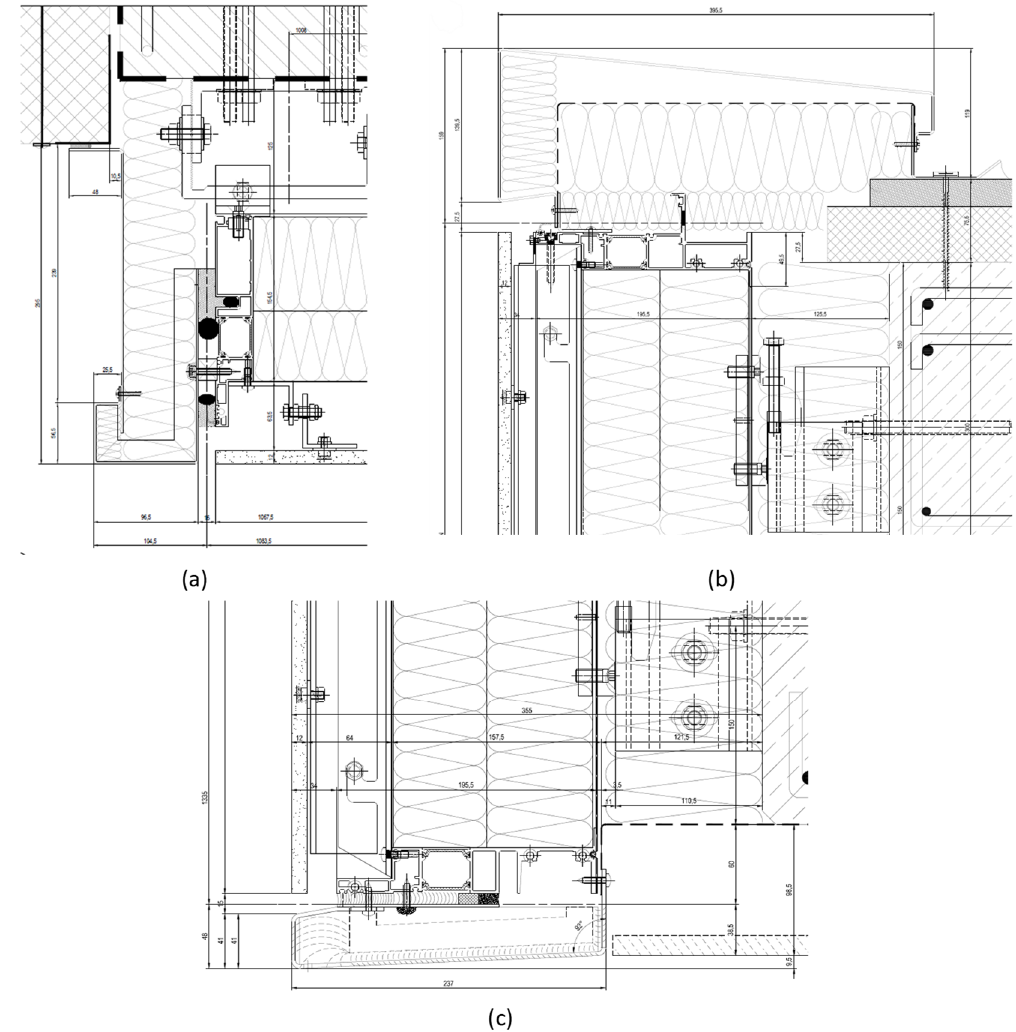
Figure 11. ( a ) Lateral closing trim; ( b ) top closing trim; ( c ) lower closing trim (measurements in mm).